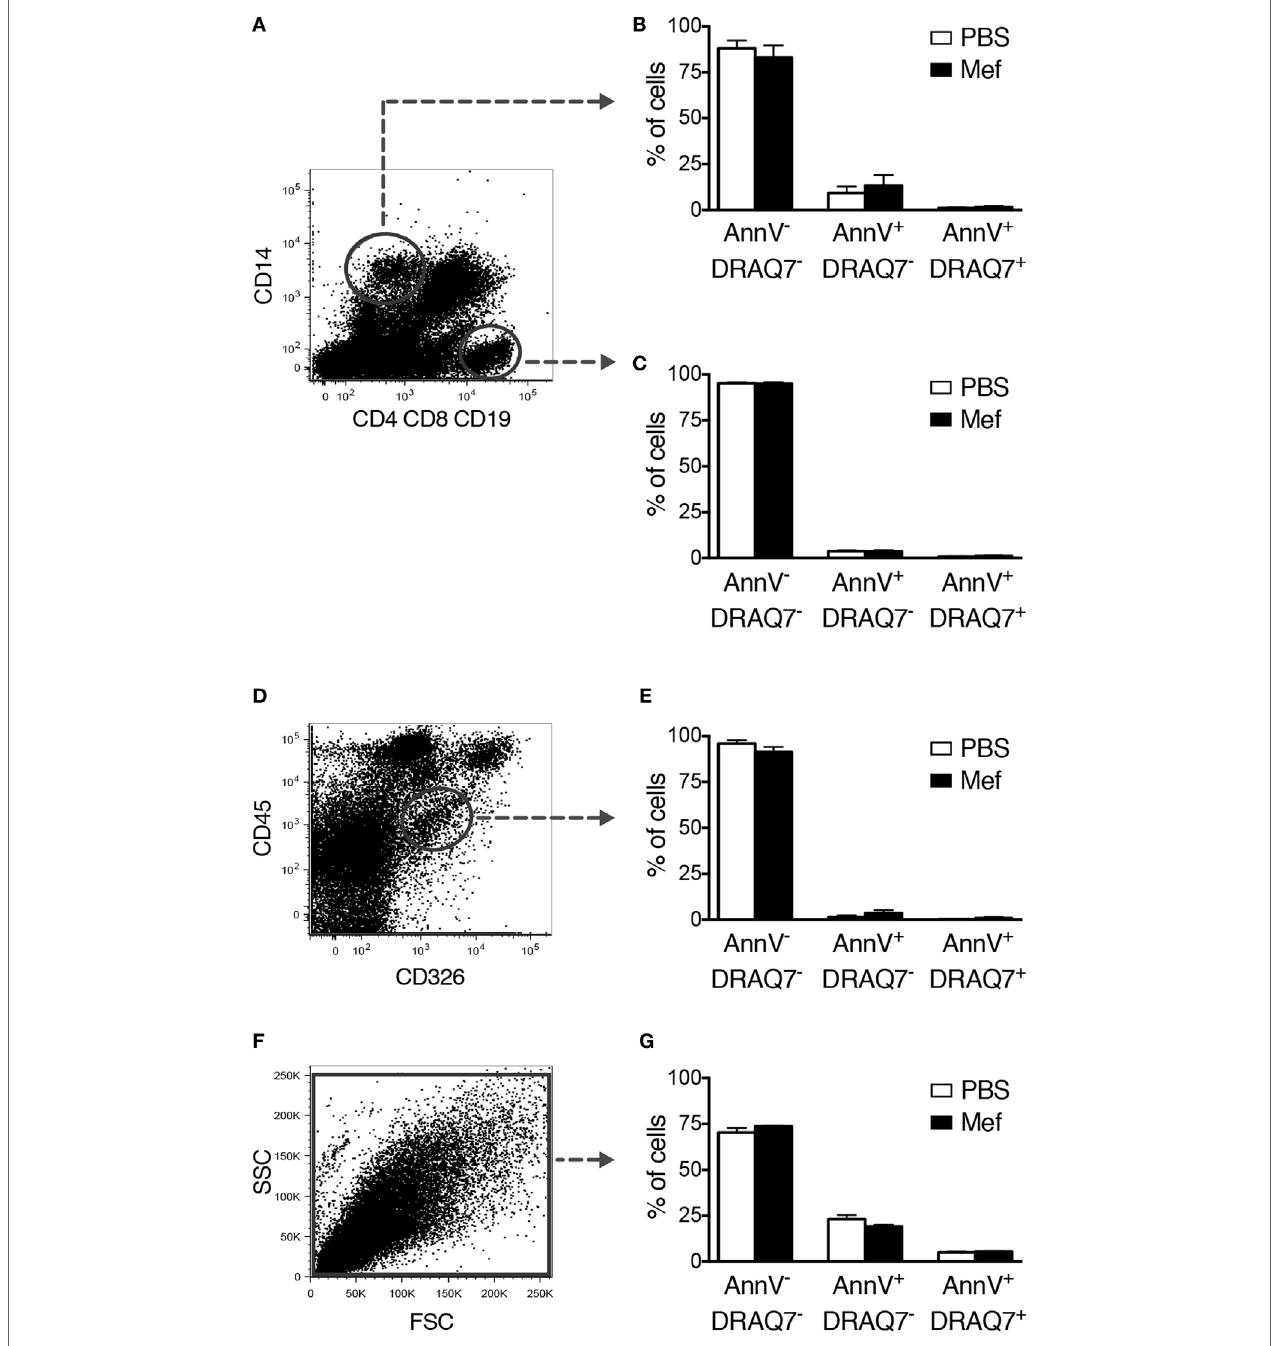
FigUre 3 | Mefloquine has no adverse effect on non-mast cell populations of the lung. Mixed human lung cells were prepared by mechanical and enzymatic treatment of lung specimens and were incubated with mefloquine (10 µM) or phosphate-buffered saline (PBS) for 24 h and then stained with antibodies recognizing the indicated surface markers. Subsequently, cell death was evaluated by flow cytometry. (a) Representative dot plots showing gated human lung CD14 + cells (monocytes/macrophages) and CD4 + CD8 + CD19 + cells (T/B lymphocytes). (B,c) Quantification of viable (Annexin V − /DRAQ7 − ), apoptotic (Annexin V + /DRAQ7 − ), and necrotic (Annexin V + /DRAQ7 + ) human lung CD14 + (B) or CD4 + CD8 + CD19 + (c) cells ( n = 4; representative of two independent experiments/two donors). (D,e) Human lung epithelial cells (CD45 − CD326 + ) were gated (D) and the percentage of viable, apoptotic, and necrotic cells were determined by flow cytometry (e) ( n = 3; representative of two independent experiments/two donors). (F,g) Primary human lung smooth muscle cells were incubated with mefloquine or PBS as described above and cell death was evaluated by flow cytometry ( n = 3; representative of two independent experiments). All data are presented as mean ±